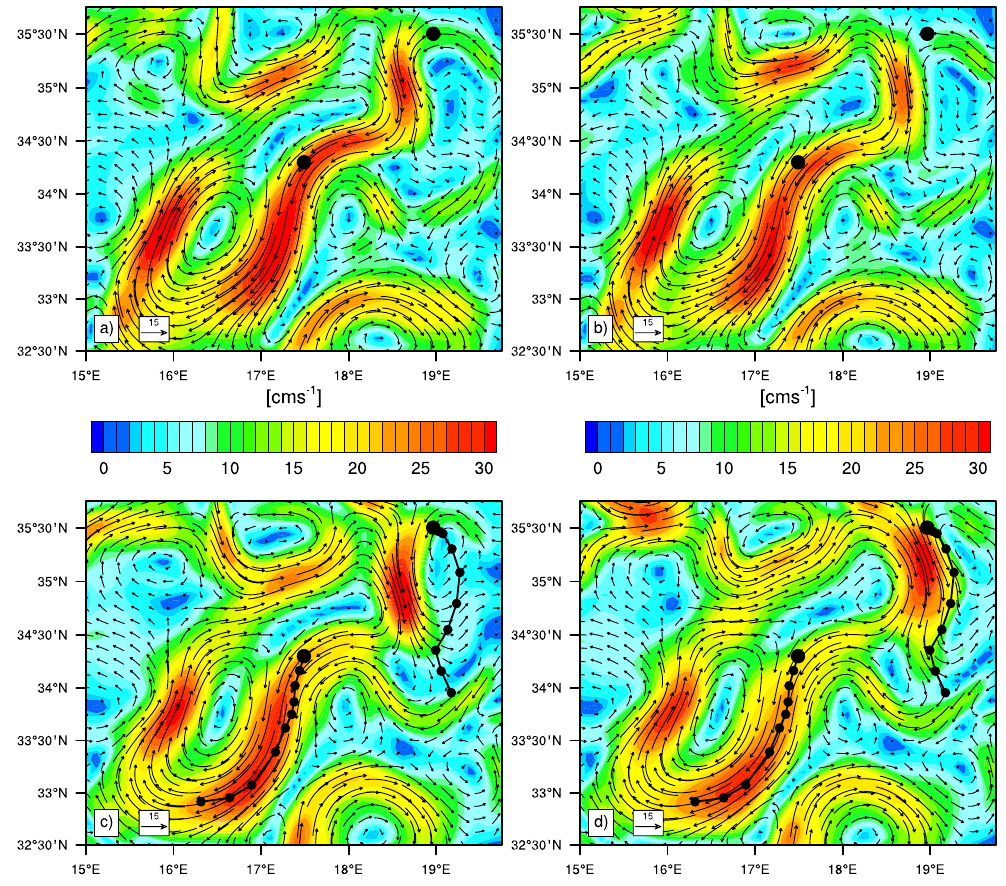
Fig. 2. Upper panels: Velocity fields at 15m depth on 1 November 2005 from the (a) CTRL, and (b) SURF experiments, with the observed surface drifter positions from platforms 57319 and 59733 on 1 November indicated by large black markers. Lower panels: Velocity fields at 15m depth on 10 November 2005 from the (c) CTRL, and (d) SURF experiments, with the daily observed surface drifter positions on 1–10 November shown by the black